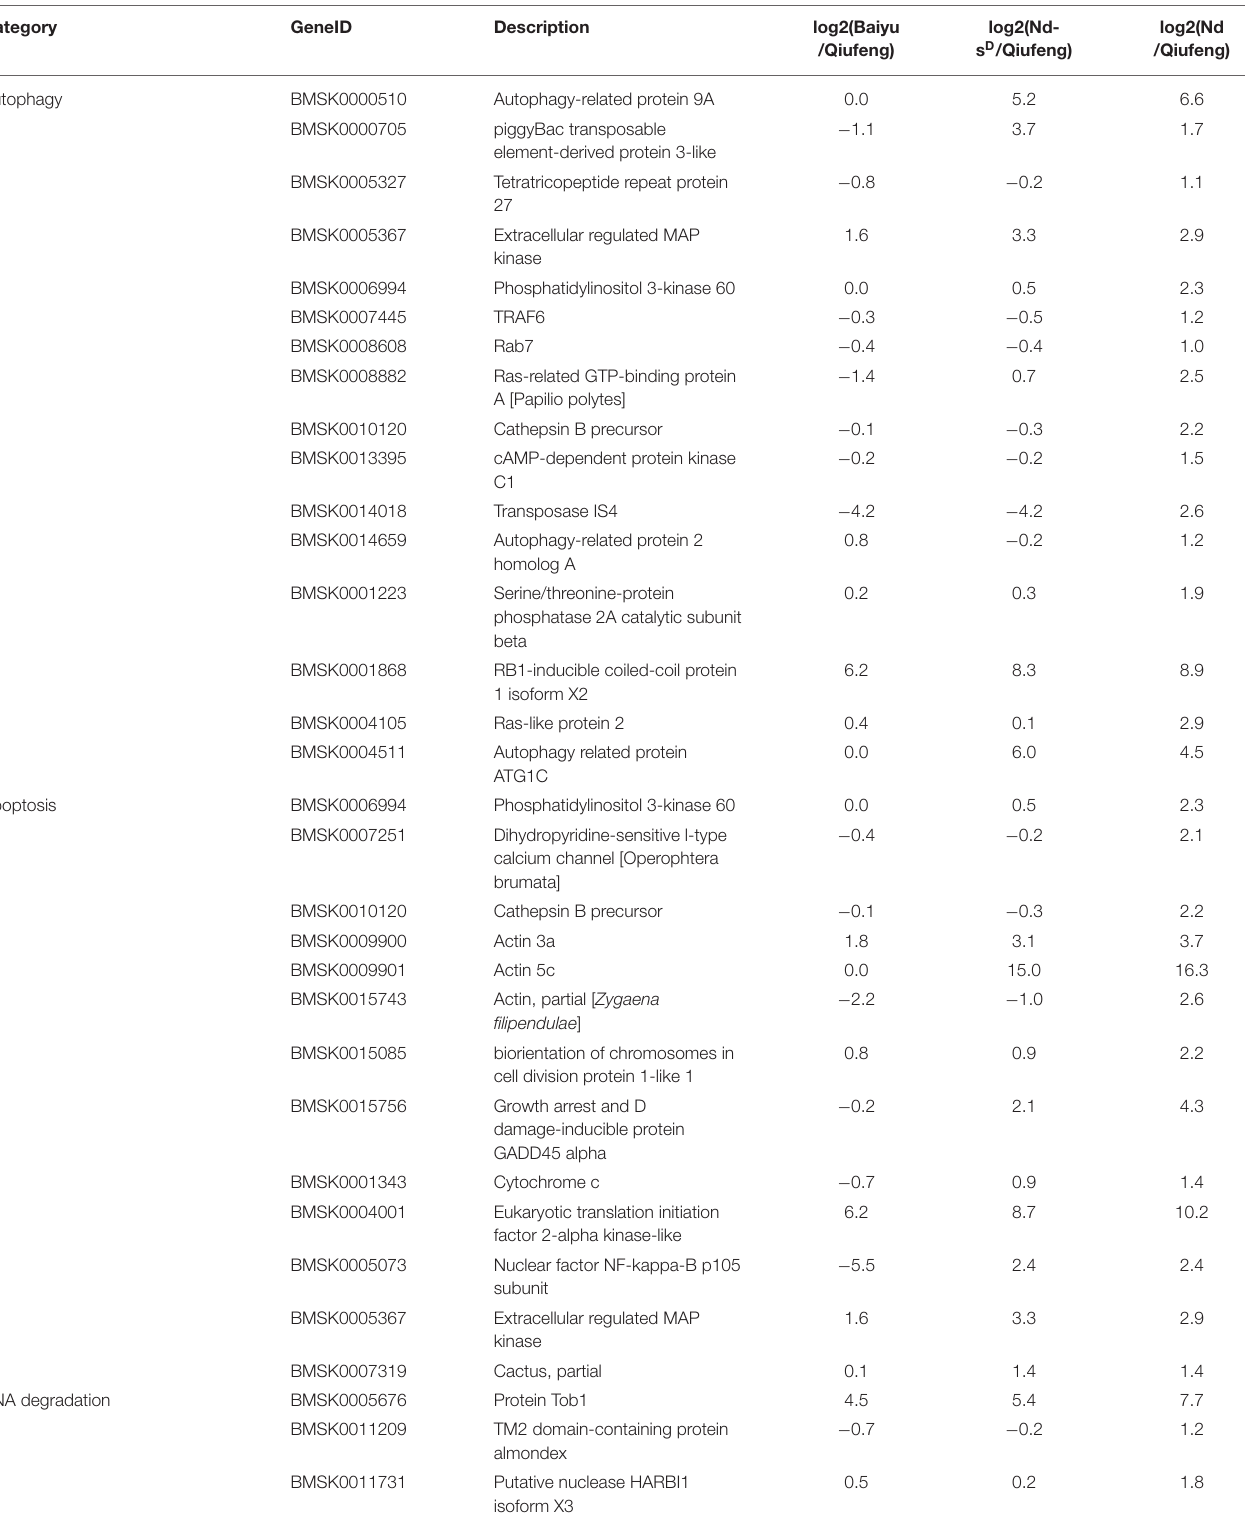
TABLE 3 | Expression levels of the target genes involved in synthesis and degradation of